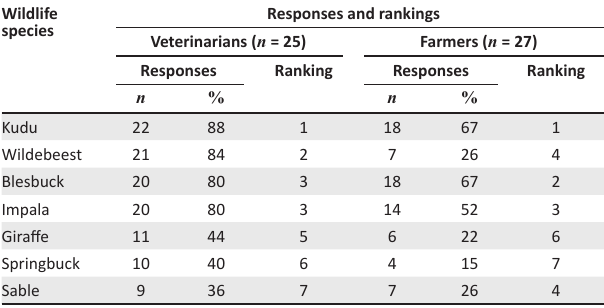
TABLE 5: Prevalence of antelope wildlife and ranking of importance from 1 being most important to 7 being least important in the spread of heartwater ticks. Wildlife species